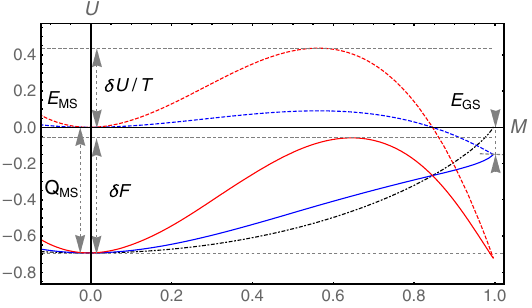
FIG. 1. Thermodynamic functions of a classical model char- acterized by the order parameter M above (blue lines) and below (red lines) the phase transition temperature. Dashed lines correspond to potential energy, and solid lines correspond to free energy that includes the entropy, shown separately by a dash-dotted black line. The difference between dashed and solid lines shows the contribution from entropy. δ F is the free energy difference that has to be overcome by classical Monte Carlo dynamics at temperatures below the transition T < T c